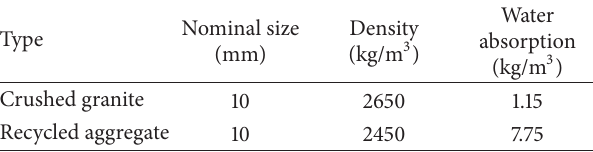
Table 1: Properties of natural and recycled coarse